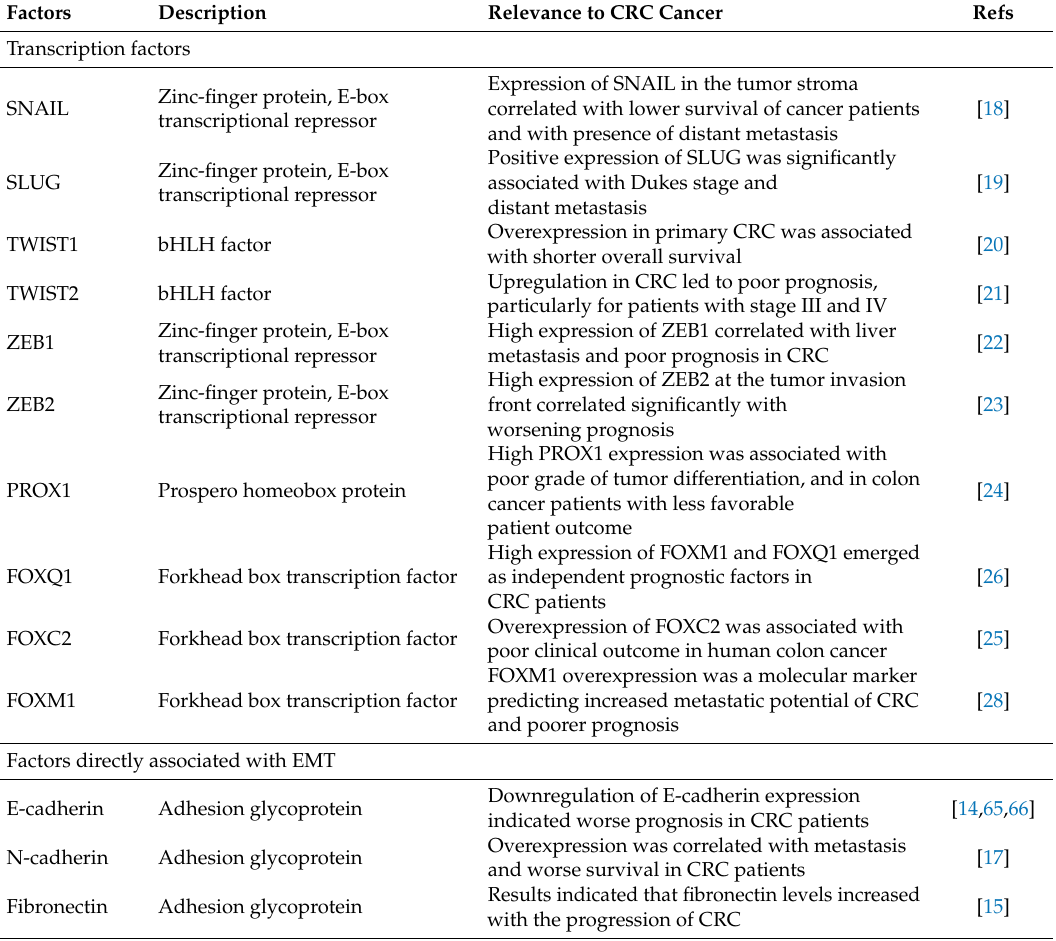
Table 1. Factors/proteins involved in EMT and their relevance to colorectal